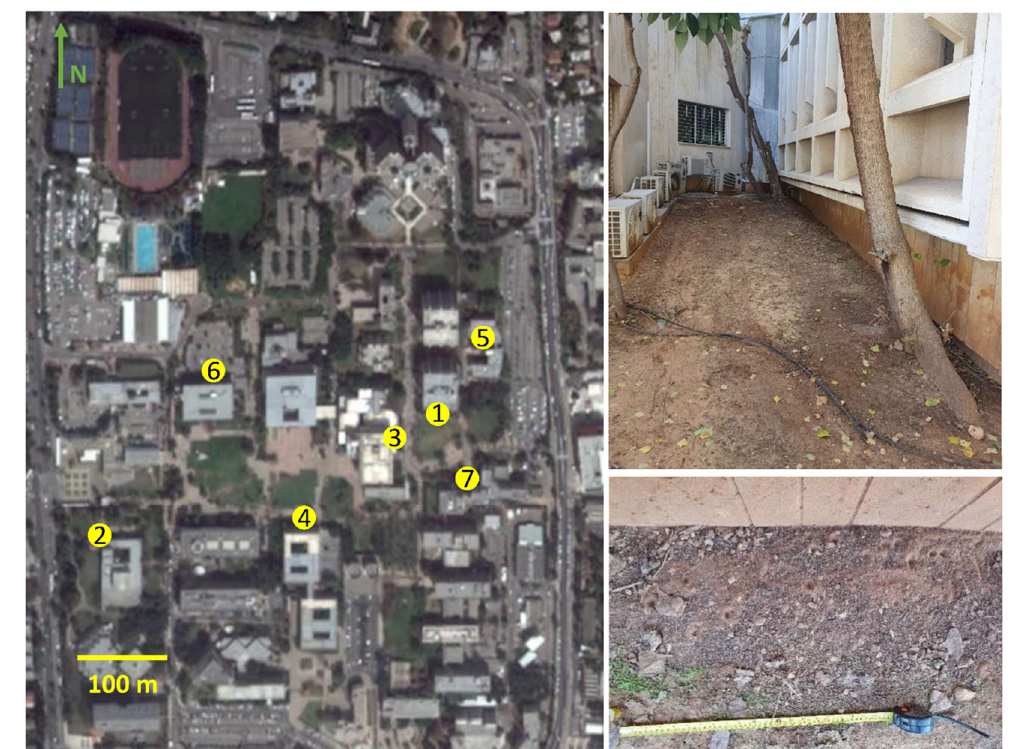
Figure 1. Clockwise: A photo of Tel Aviv University (Tel Aviv, Israel, from Google Earth) with the seven study sites marked. An overview of one site (Schreiber building), and the wormlion pits adjacent to the building’s wall. The numbers stand for sites: (1) Britannia, (2) Buchmann-Mehta, (3) Central library, (4) Gilman, (5) Green, (6) Mexico, and (7) Schreiber.